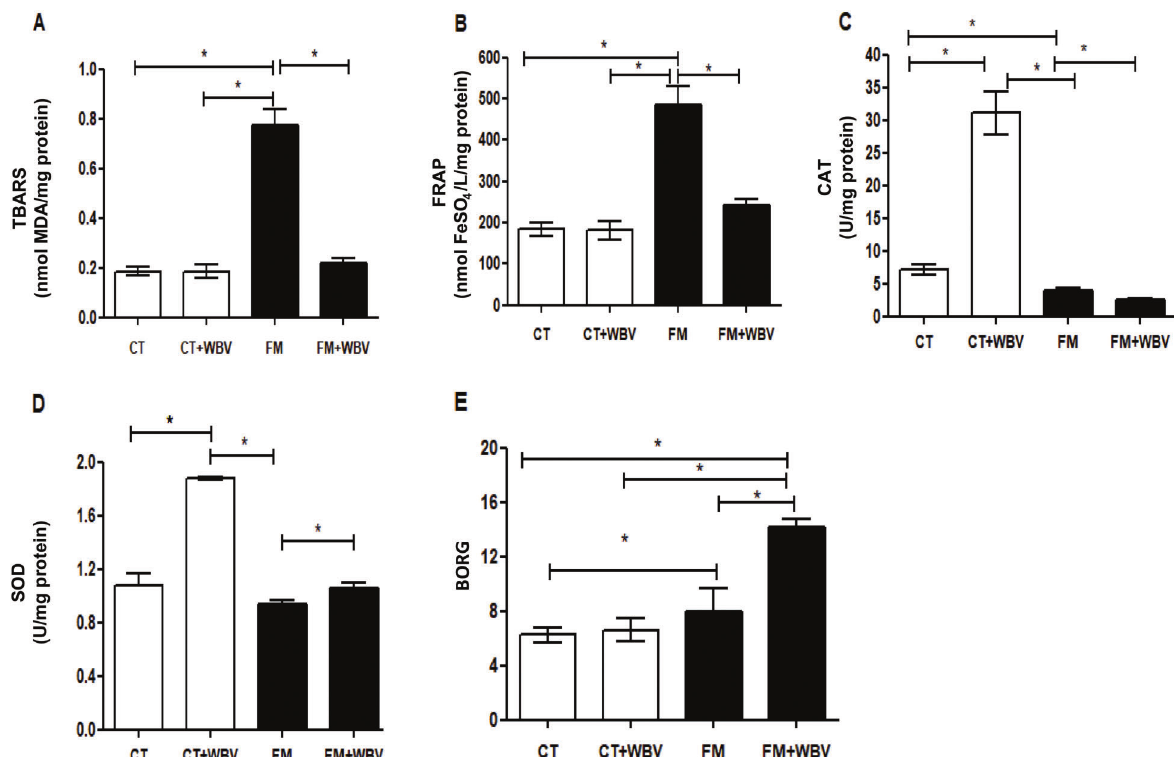
Figure 2. Treatment effects for oxidative markers in healthy controls (CT) and fi bromyalgia (FM) female patients treated or not with whole body vibration (WBV) exercise. A , thiobarbituric acid reactive substances (TBARS); B , iron reduction capacity (FRAP); C , catalase (CAT); D , superoxide dismutase antioxidant enzymes activity (SOD); E , Borg scale scores. Data are reported as means ± SE. *P o 0.05